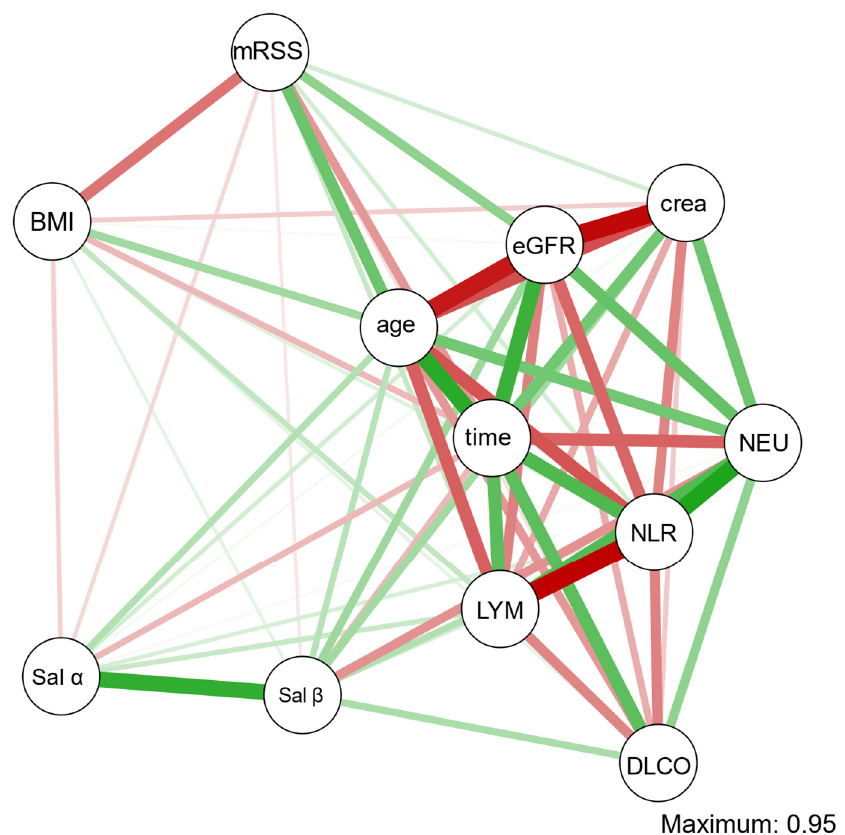
Figure 3. Gaussian graphical model for continuous variables evaluated in the experimental group. Legend: crea—serum creatinine concentration; DLCO—diffusion lung capacity for carbon monox- ide; time—disease duration; eGFR—estimated glomerular filtration rate; LYM—lymphocyte per- centage; mRSS—modified Rodnan scale score; NLR—neutrophil to lymphocyte ratio; NEU—neu- trophils percentage; Sal α —serum salusin- α ; Sal β —serum salusin- β . Green color—positive partial correlation; red color—negative partial correlation; thickness of the line reflects the strength of the correlation.